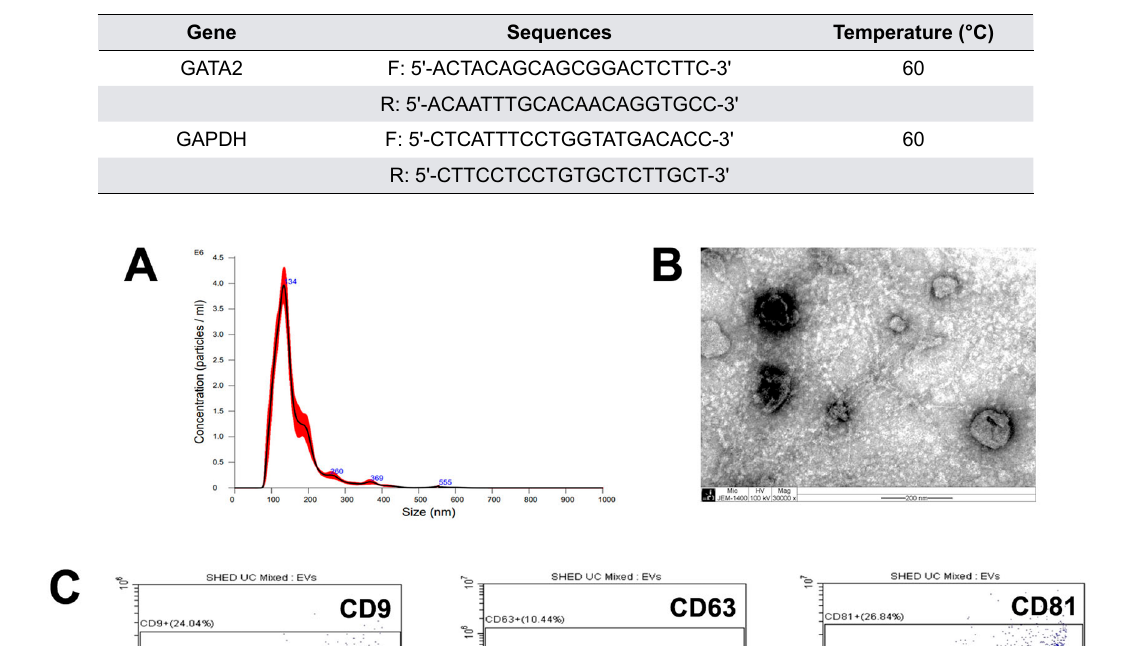
Table 1- Primer sequences for real-time PCR